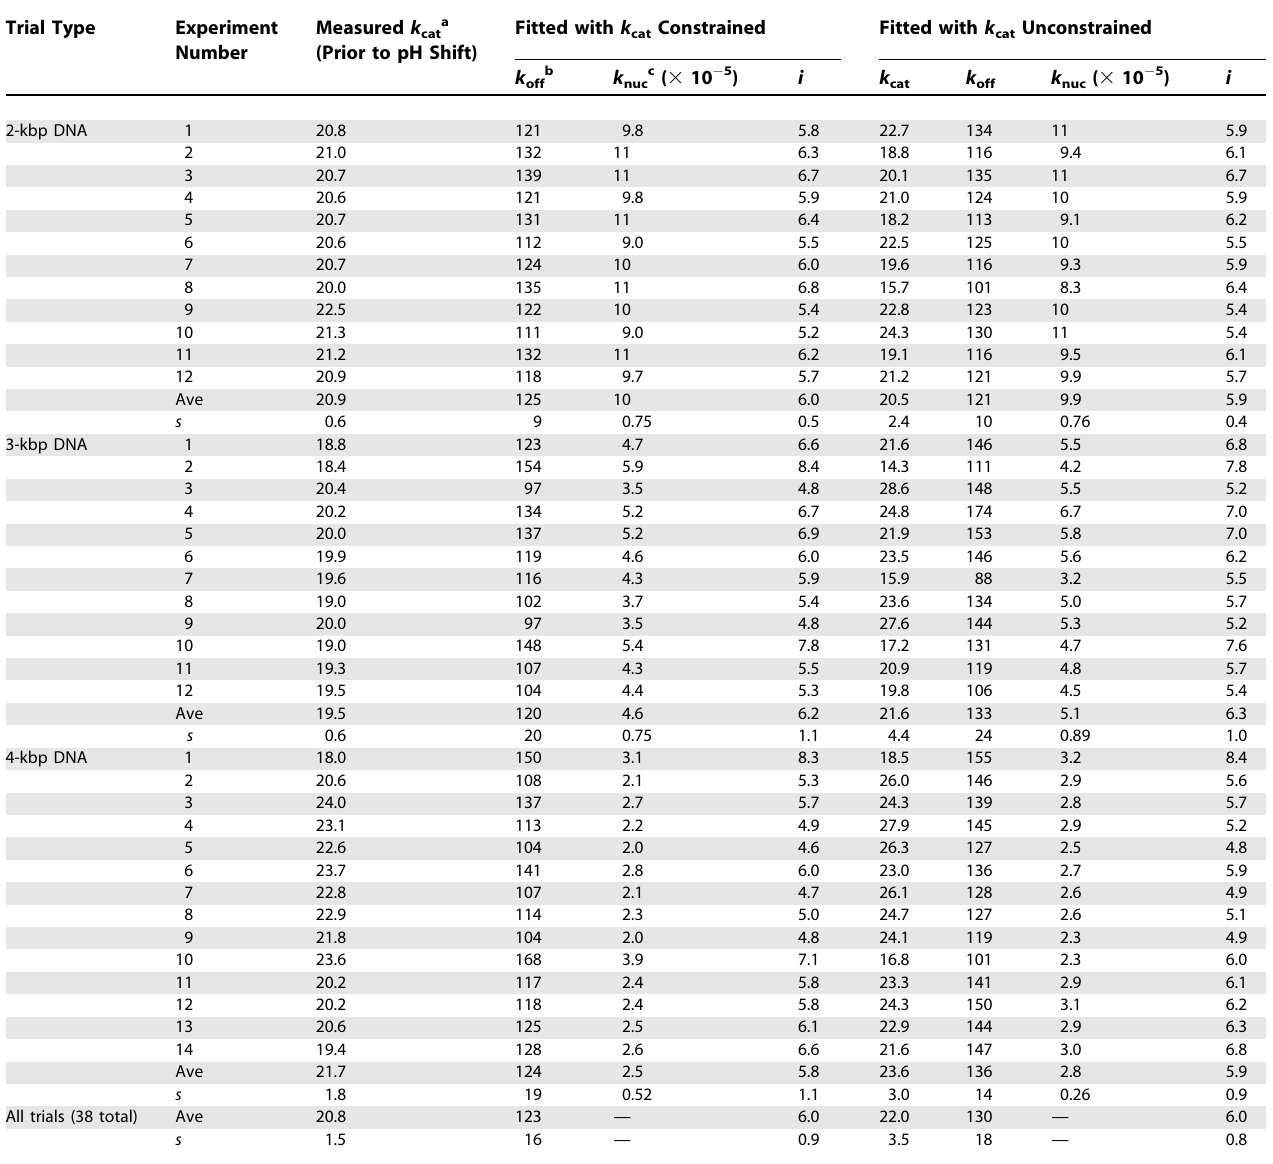
Table 1. Experimental Parameters Obtained in Individual RecA Filament Disassembly Trials Trial Type Experiment Measured k cata Fitted with k cat Constrained Number (Prior to pH Shift)